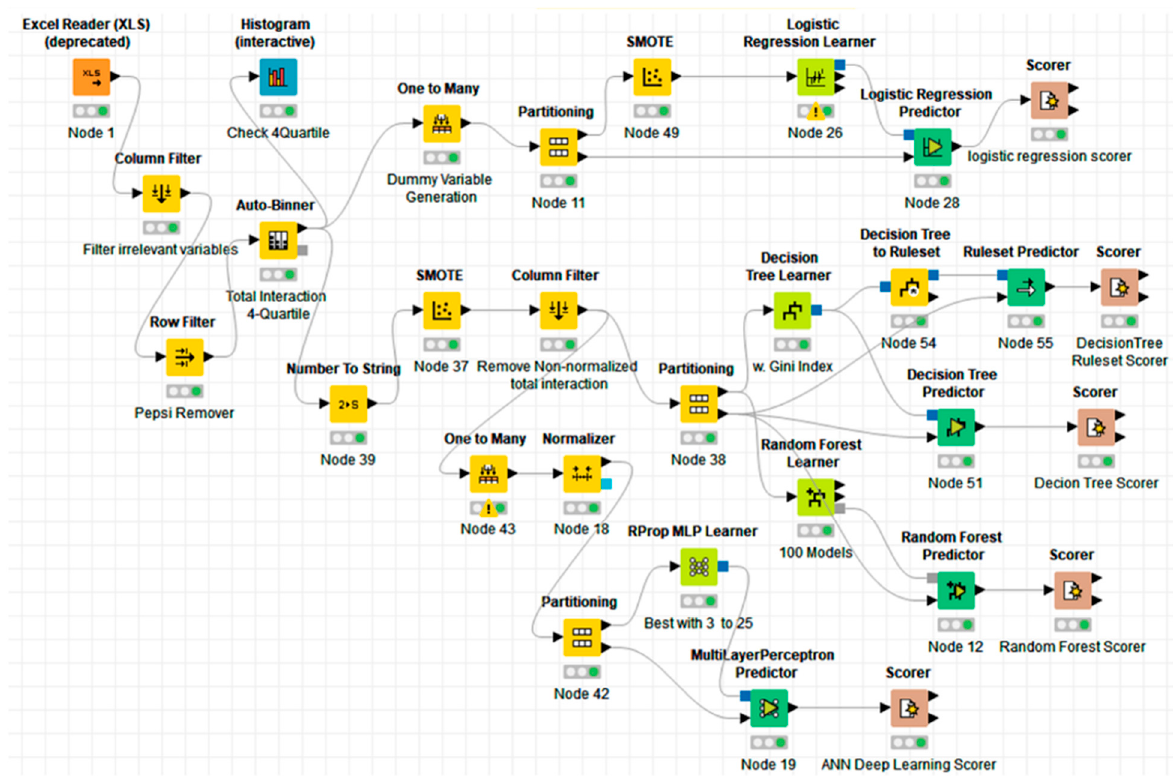
Figure A2. Knime Analysis framework.